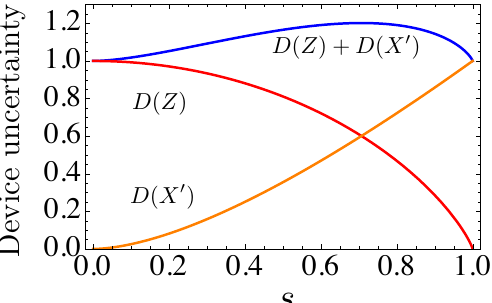
Figure 3. For a pair of jointly measurable observables Z and X (cid:48) obtained via successive measurement scheme, we plot device uncertainties of them and their summation denotes by D ( Z ) , D ( X (cid:48) ) and D ( Z ) + D ( X (cid:48) ) , respectively, versus the unsharp parameter s . We can observe trade-off relation between D ( Z ) and D ( X (cid:48) ) characterizing unsharpness of Z and X (cid:48)